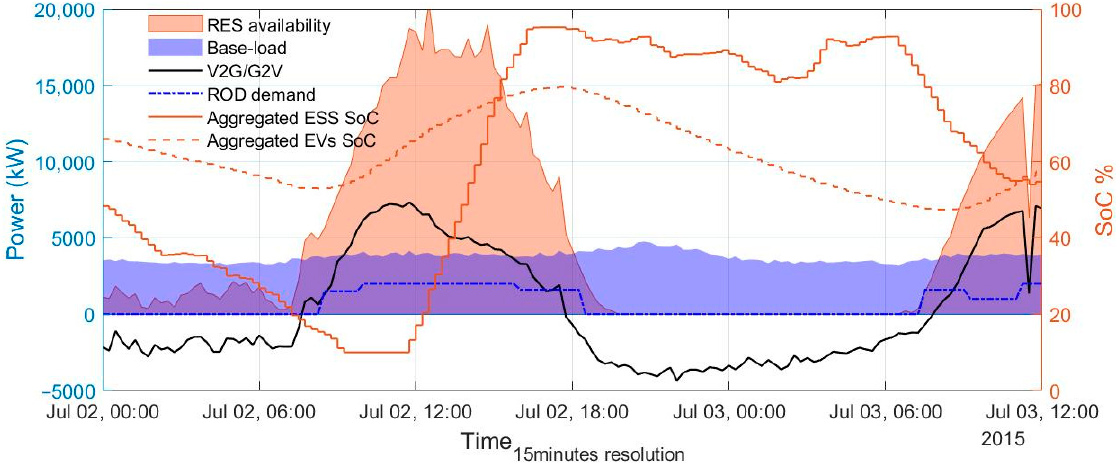
Figure 10. The result of optimized, integrated management of resources during 36 h. The solid black line represents the aggregated V2G/G2V power in kW.